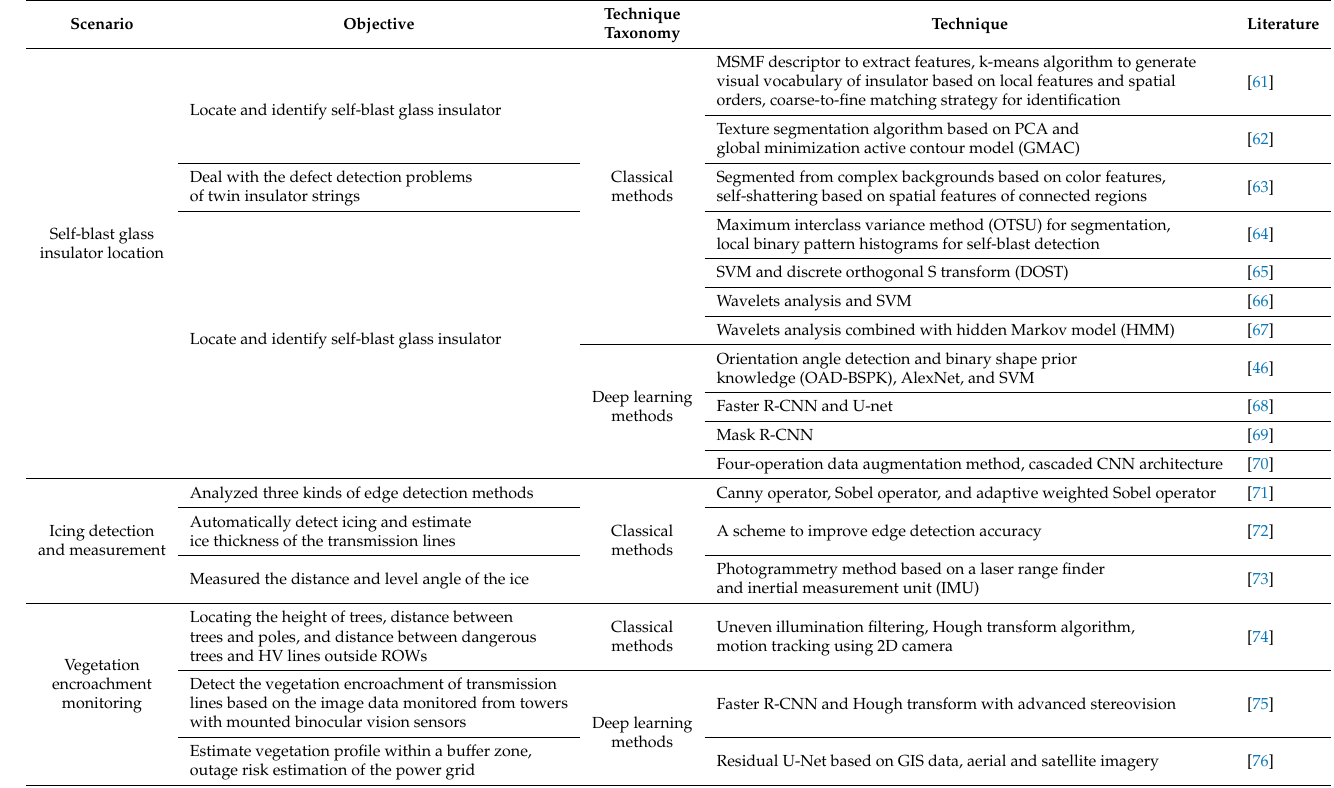
Table 1. Visible-light-based abnormality